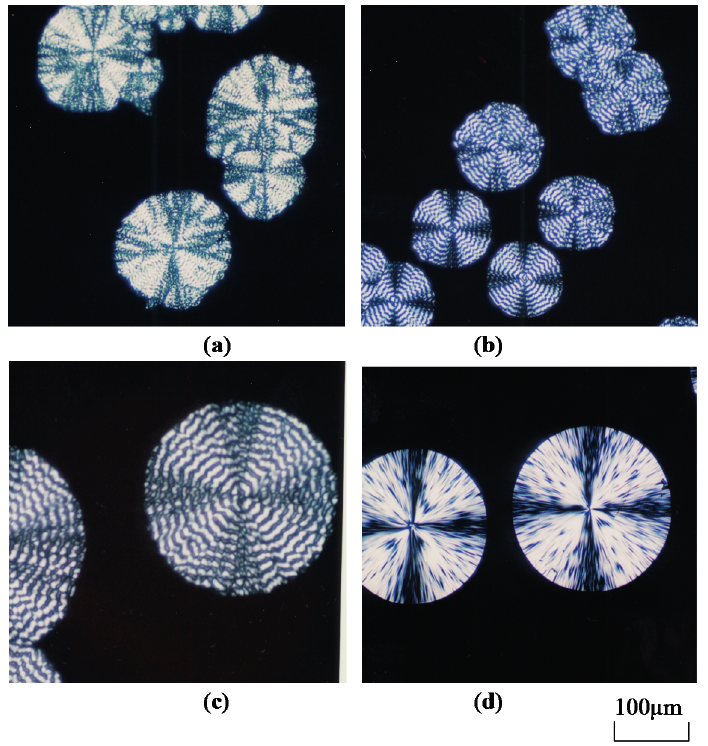
Figure 21. Time evolution of relaxation enthalpy ∆ H estimated for PLLA ( ■ ) and CA 2.15 - g -PLLAs at MS values of 4.7 ( ● ) and 22 ( ○ ). The aging temperature amounted to 50 °C. Reproduced with permission from ref. [58]. Copyright 2004 American Chemical Society.